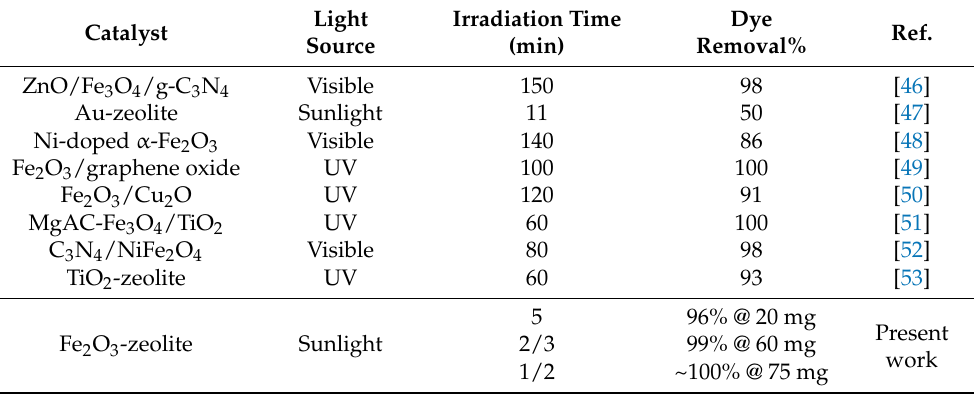
Table 4. Comparison of the efficiency of the current photocatalysts with the literature values for iron oxide and/or zeolite-based photocatalysts